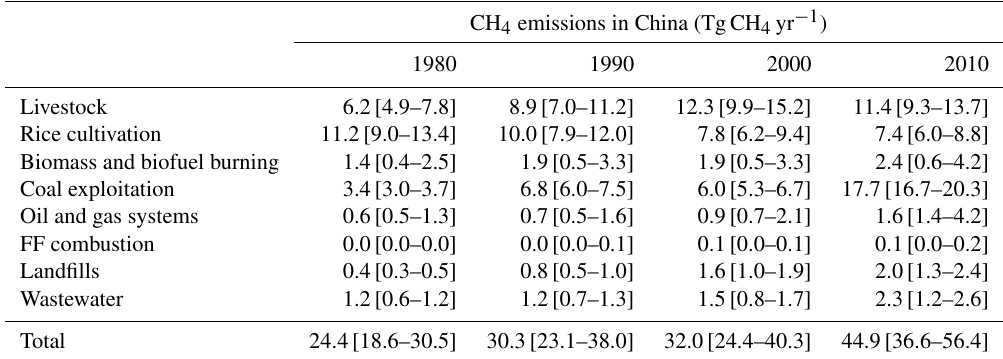
Table 3. Total CH 4 emissions from the eight major source sectors and their total in mainland China in 4 snapshot years (1980, 1990, 2000 and 2010). Values are given in TgCH 4 yr − 1